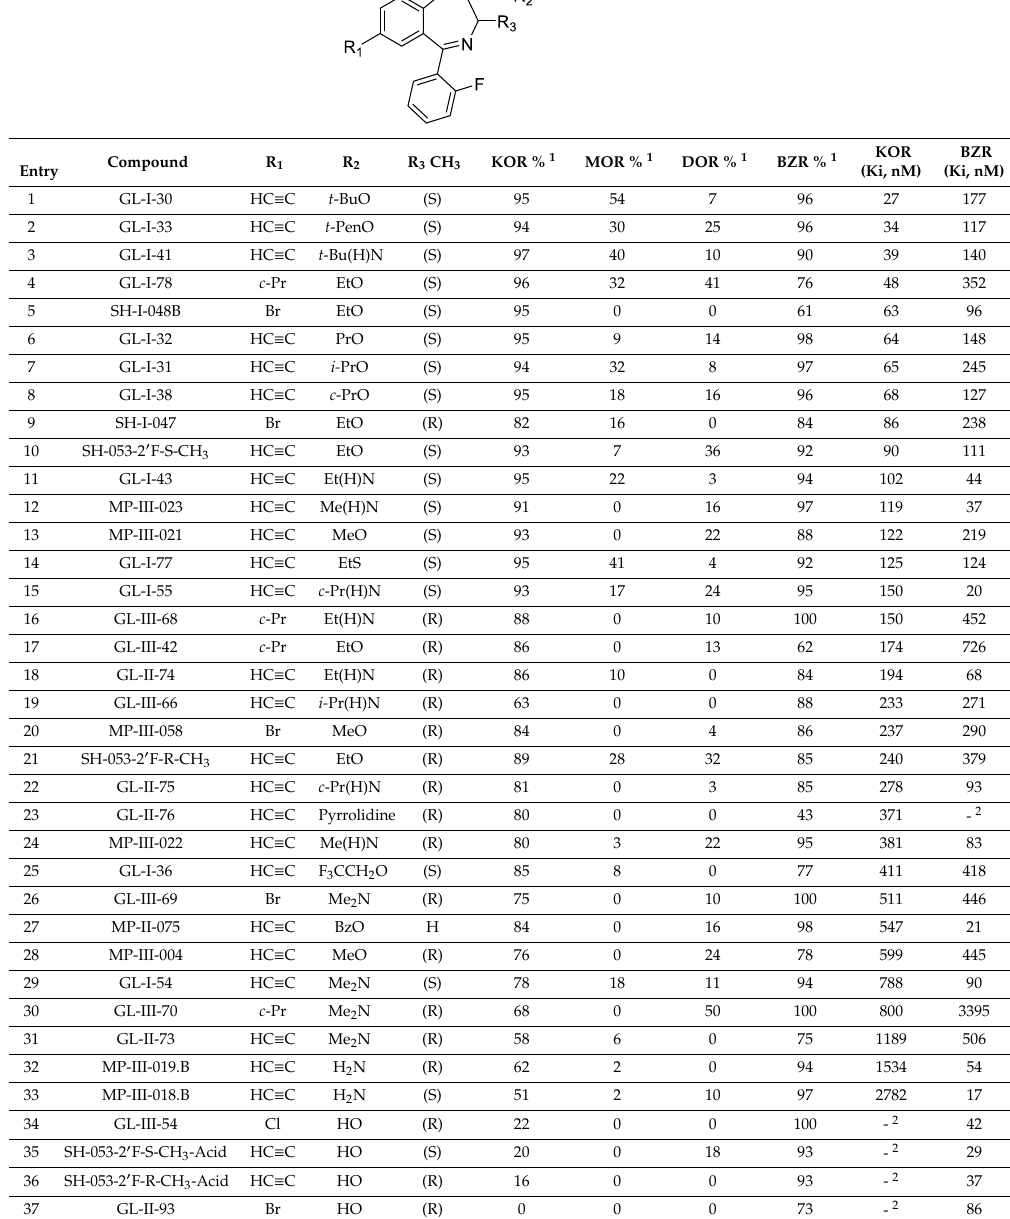
Molecules 2020 , 25 , x FOR PEER REVIEW 3 of 12 substituents such as propyl, ethyl, or methyl (Table 1, entries 1, 6, 10, and 13). The KOR affinity difference between t -butyl and methyl ester was 4.5-fold. Interestingly, the change from an ethyl to a trifluoroethyl ester reduced KOR affinity by 4.5-fold (Table 1, entries 10 vs. 25). A similar trend was observed for amides. The change from a t -butyl to methyl amide reduced KOR binding by 3.1-fold (Table 1, entries 3 vs. 12). The thioester GL-I-77 exhibited KOR affinity similar to the corresponding ester (Table 1, entries 10 vs. 14). N,N ′ -Dimethyl amides were poor KOR ligands. The change from an N -methyl amide to N,N ′ -dimethyl amide reduced KOR affinity by 6.6-fold (Table 1, entries 12 vs. 29). Non-substituted amides as well as carboxylic acid ligands exhibited very low KOR affinities. No KOR affinity was observed for GL-II-93 (MIDD0301) (Table 1, entry 37). Interestingly, the BZR affinity for non-substituted amide and carboxylic acid imidazodiazepines was below 100 nM (Table 1, entries 32 – 37). The R 1 cyclopropyl group that improved KOR affinity significantly reduced BZR affinity in comparison to a bromo substituent (Table 1, entries 4 vs. 5, 9 vs. 17 and 26 vs. 30). Similar to KOR, (S) methyl imidazodiazepines showed better BZR affinities than (R) isomers. In some cases the affinity difference was 5.6-fold (Table 1, entries 29 vs. 31). Table 1. Opioid and benzodiazepine receptor binding of 2′ -fluorophenyl substituted Table1. Opioidandbenzodiazepinereceptorbindingof2 (cid:48) -fluorophenylsubstitutedimidazodiazepines.